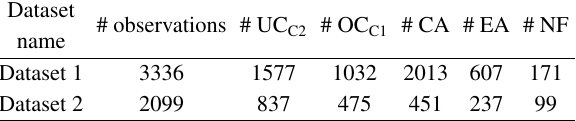
Table 5 List of faults with fault counts for datasets. Dataset